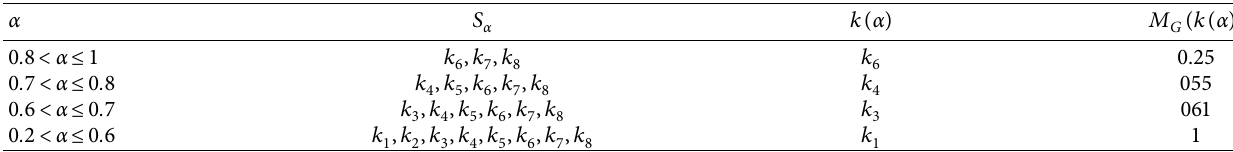
Table 10: Absolutely optimal